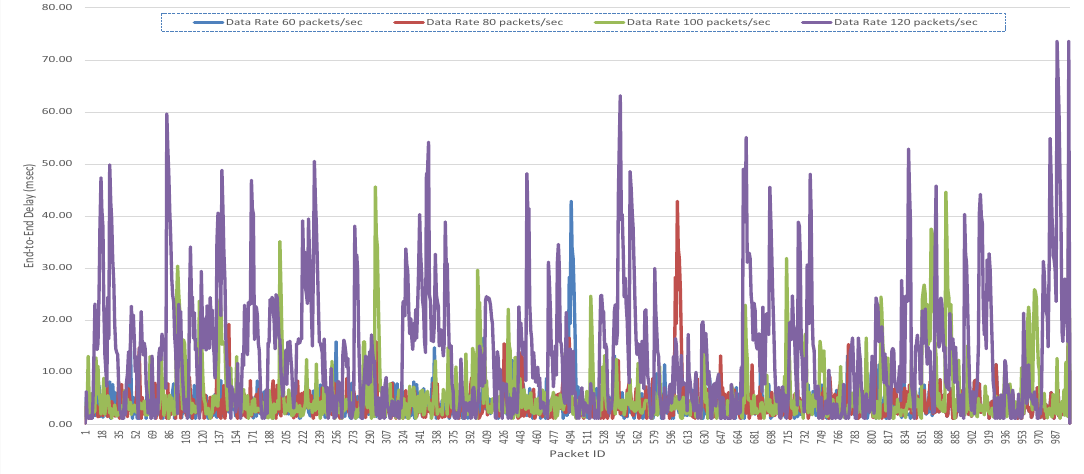
Figure 14. End to end delay.